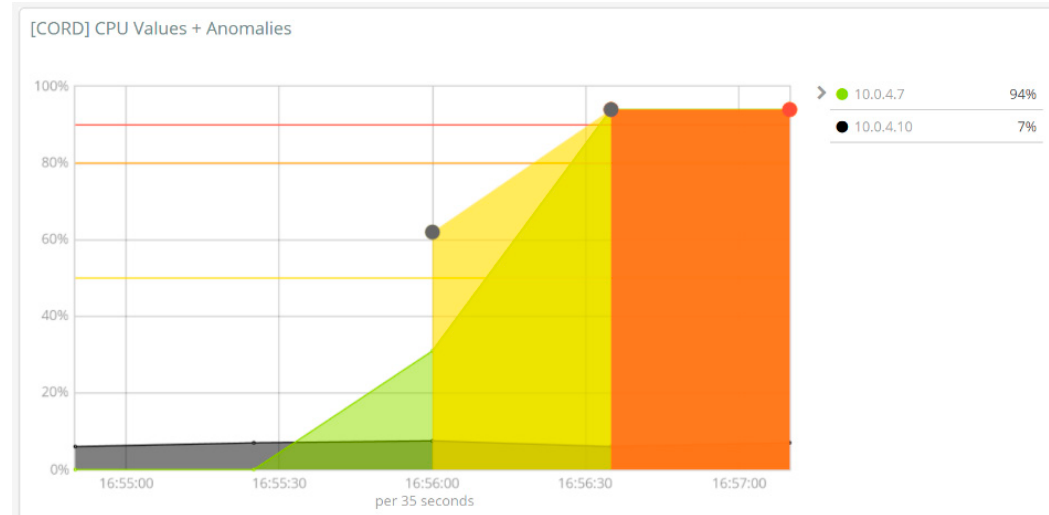
Figure 11. CPU Monitoring/Healing Dashboard of Telco PaaS.